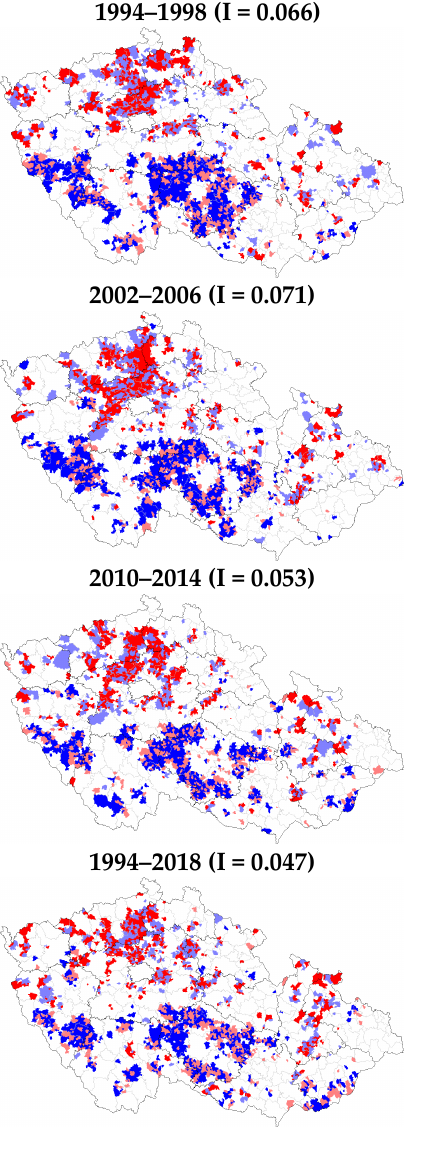
Figure 3. Bivariate local indicators of spatial association (LISA) cluster maps for women’s descriptive representation in Czech local elections for the period from 1994 to 2018. Source: Czech Statistical Office; own calculation. Note: All LISA cluster maps are calculated for distance-based spatial weights with a fixed Euclidean distance and a threshold distance of 10 km.